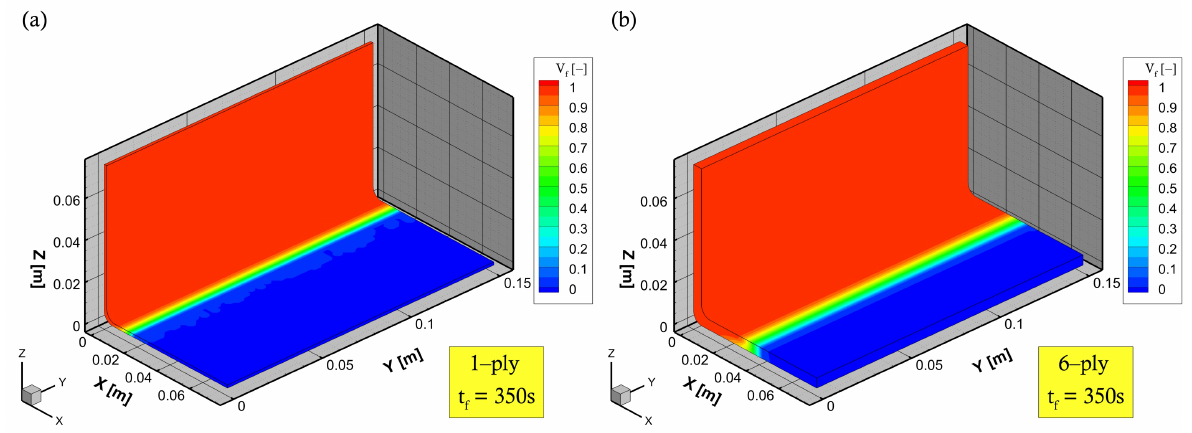
Figure 9. Three-dimensional numerical mould-filling process of a curved-type (L-shaped) composite component. ( a ) 1-ply ( b )